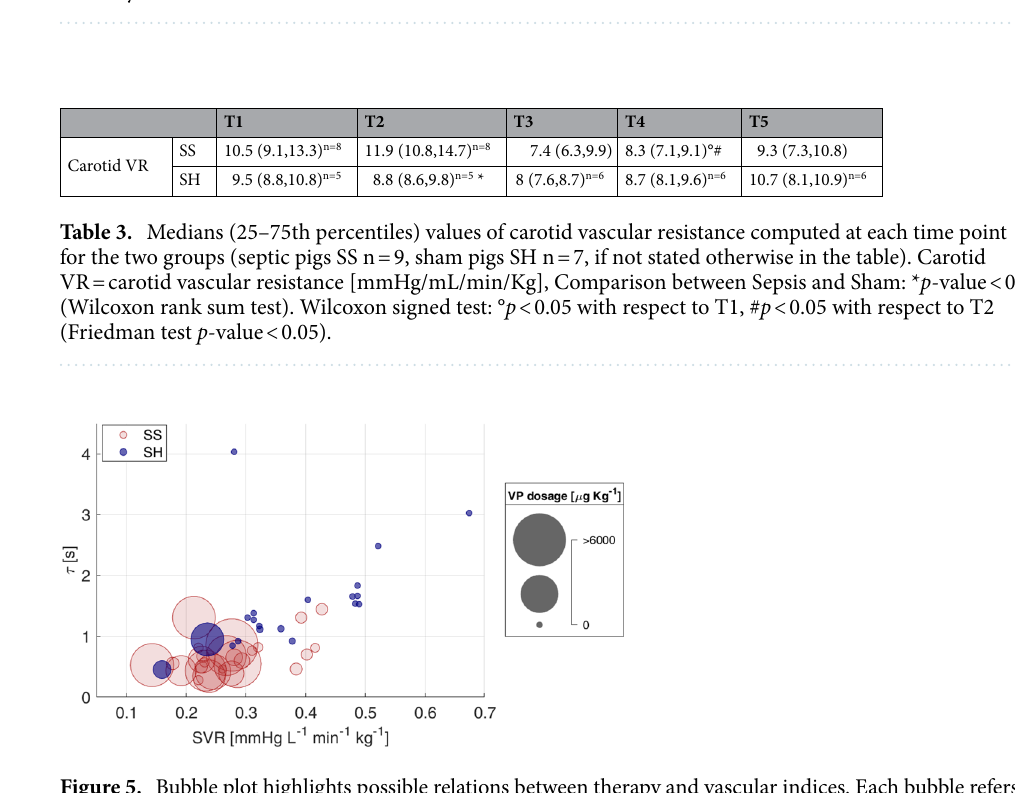
Figure 5. Bubble plot highlights possible relations between therapy and vascular indices. Each bubble refers to a pig at T3, T4 or T5 and the radius is proportional to vasopressor